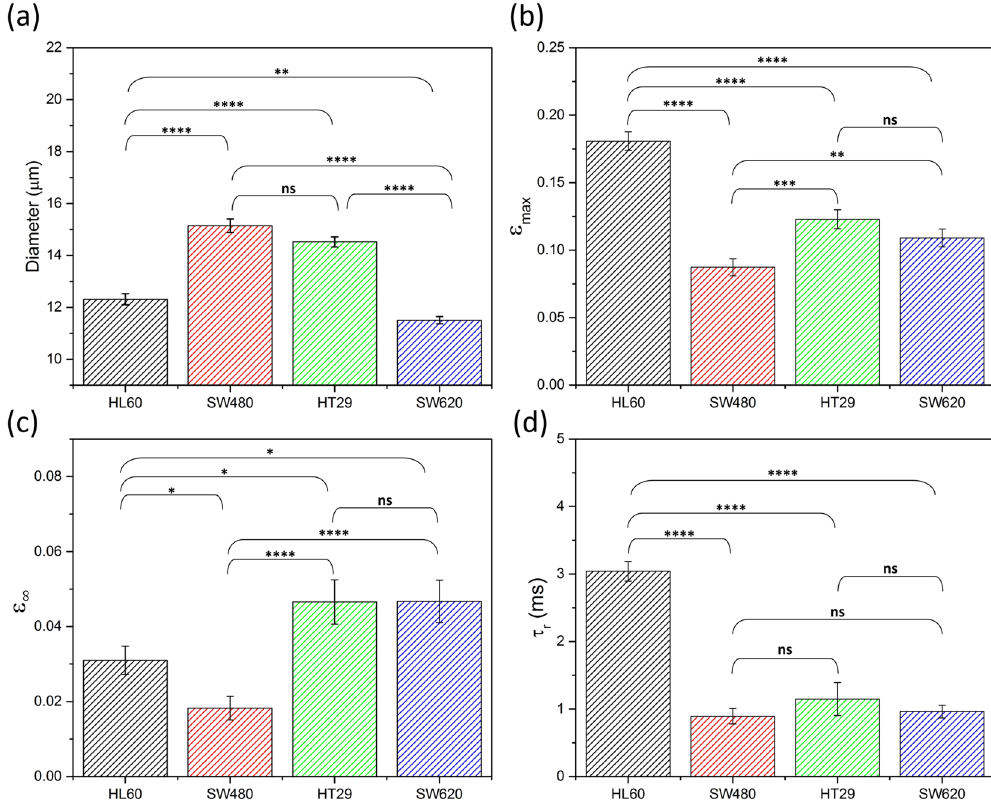
Figure 4. Multiparameter analysis of HL60, SW480, SW620 and HT29 cell populations. The error bars denote the standard error SE, statistical t-tests were done to determine the level of significance. ( a ) Initial cell diameter, ( b ) The maximum strain ε , ( c ) the final strain ε ∞ and ( d ) the relaxation time τ were extracted from max r deformation traces of single cells deforming at 5 µ l/min in a shear dominant regime (~33